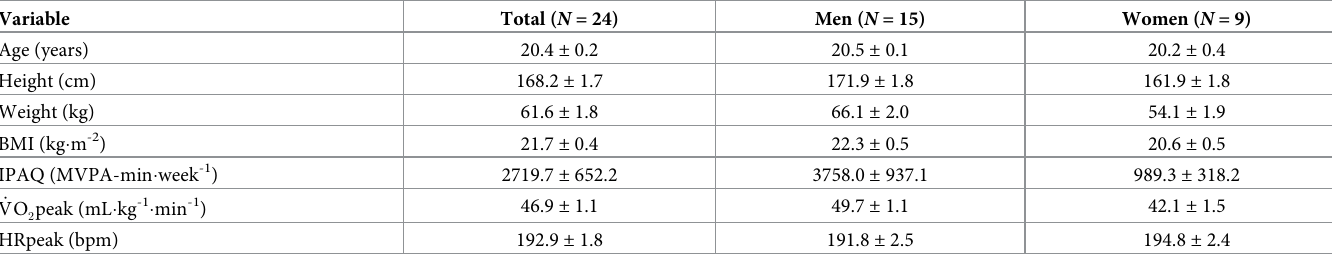
Table 1. Characteristics of the participants (mean ±